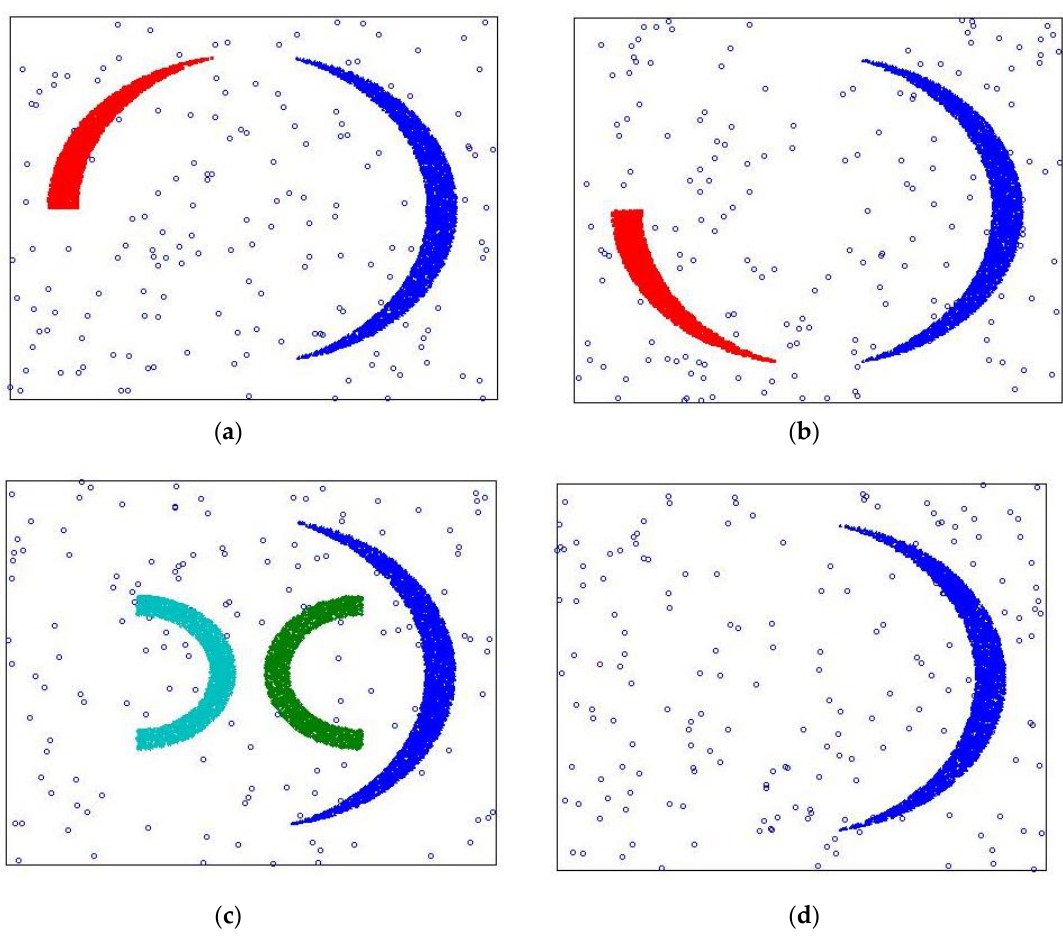
Figure 9. MDDSDB-GC algorithm experimental results. ( a ) T = 1, initial clustering result; ( b ) T = 2, second time window, cluster drift; ( c ) T = 5, the fifth time window, the emergence of new cluster; ( d ) T = 6, the sixth time window, the disappearance of old cluster.